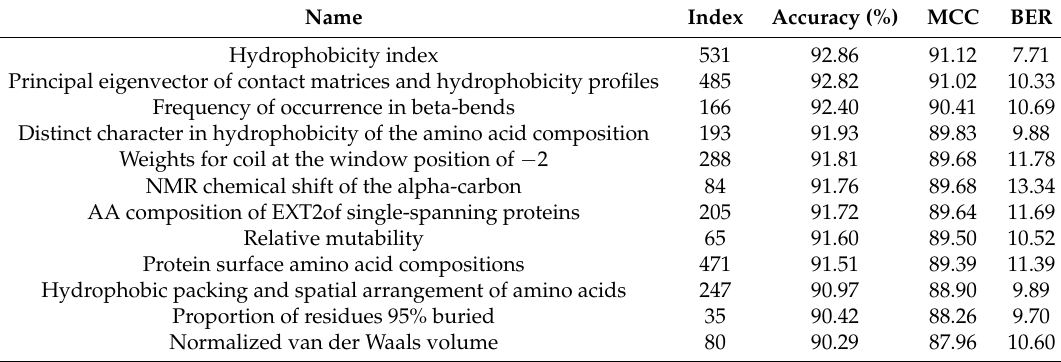
Table 10. Highest average accuracy results of the restricted Boltzmann machine (RBM) with two hidden layers over 531 amino acid property indices. MCC, Matthews’ correlation coefficient; BER, balanced error